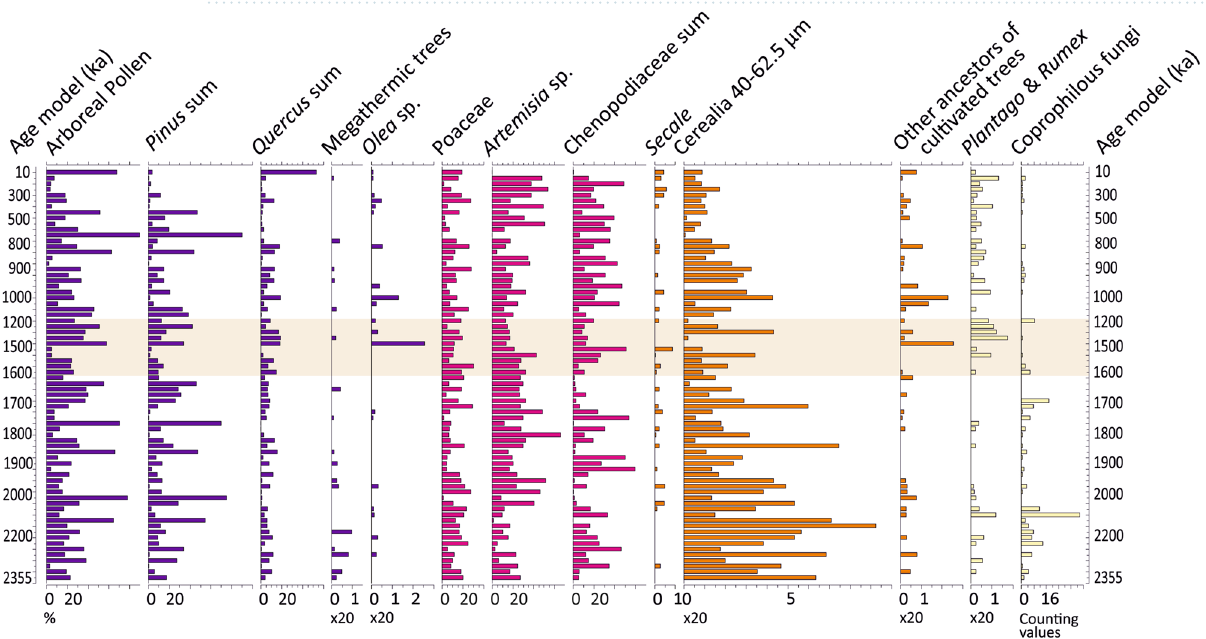
Figure 3. Simplified pollen and NPP diagram in percentages of Acıgöl, core 3, based on the age model of Demory et al. [1]. Equidistant scale. Values are in percentages calculated on a pollen sum without Non-Pollen Palynomorphs (NPP), Ferns, Bryophytes and Algae. The beige rectangle corresponds to the date of the presence of Homo erectus at Kocabaş (Lebatard et al.